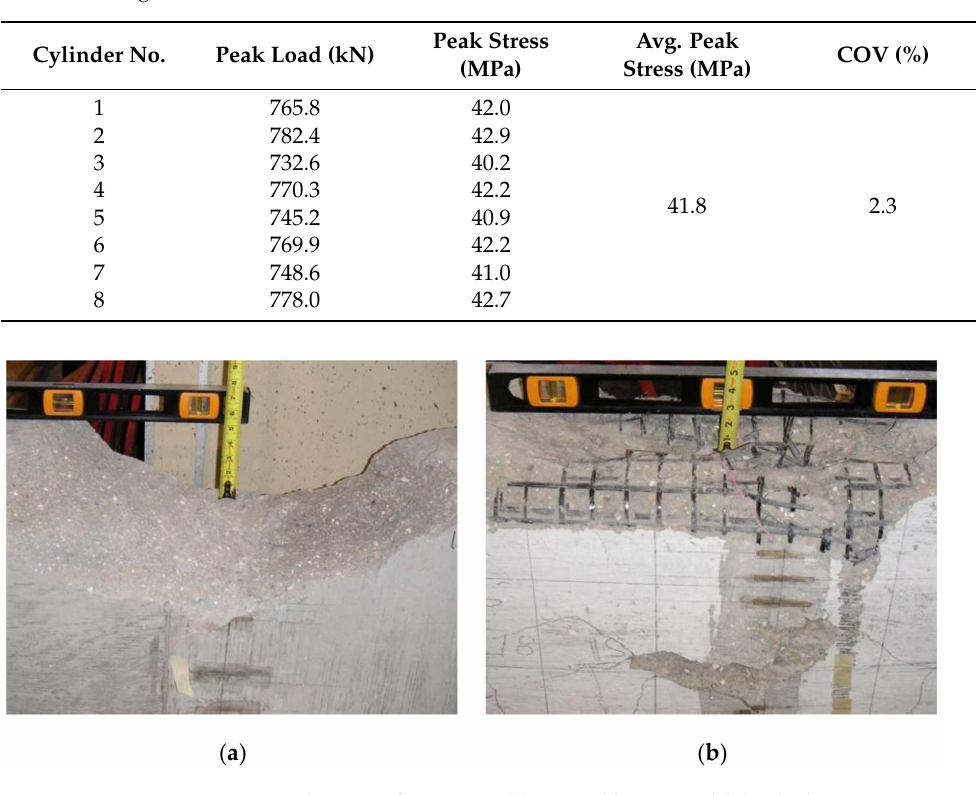
Figure 14. Compression zone damage after testing ( a ) control beam, and ( b ) tube beam.